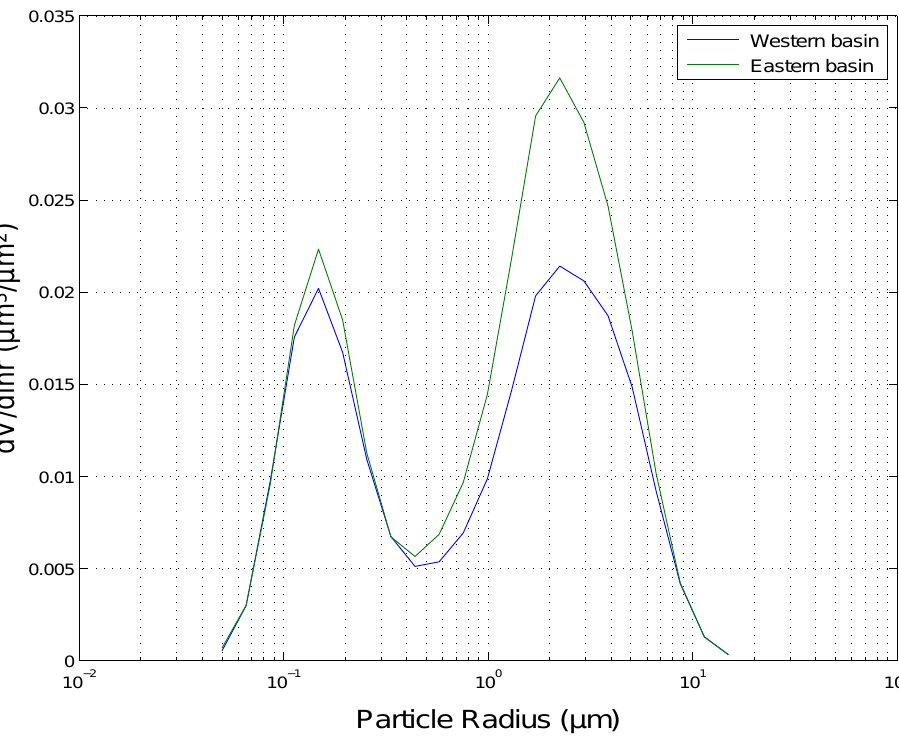
Fig. 8. AERONET level-2 aerosol volume size distribution averaged over the 8 eastern and 14 western sites (see Table 1). Inversion is performed in 22 logarithmically equidistant size bins between 0.05 and 15 µm in radius. Adjusted parameters are given in Table 3.